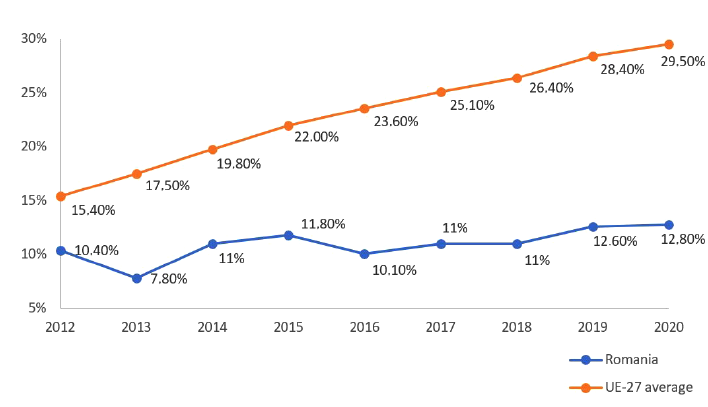
Figure 1. The share of female executives in Romania compared to EU-27 level (period 2011–2020) % (source: own projection based on European Institute for Gender Equality, 2020a) If in the case of the EU-27 average (except Great Britain) we notice a strong increase in the share of female executives, in the case of Romania this share fluctuates every year, with values between 7.8% and 12.8%, well below the EU